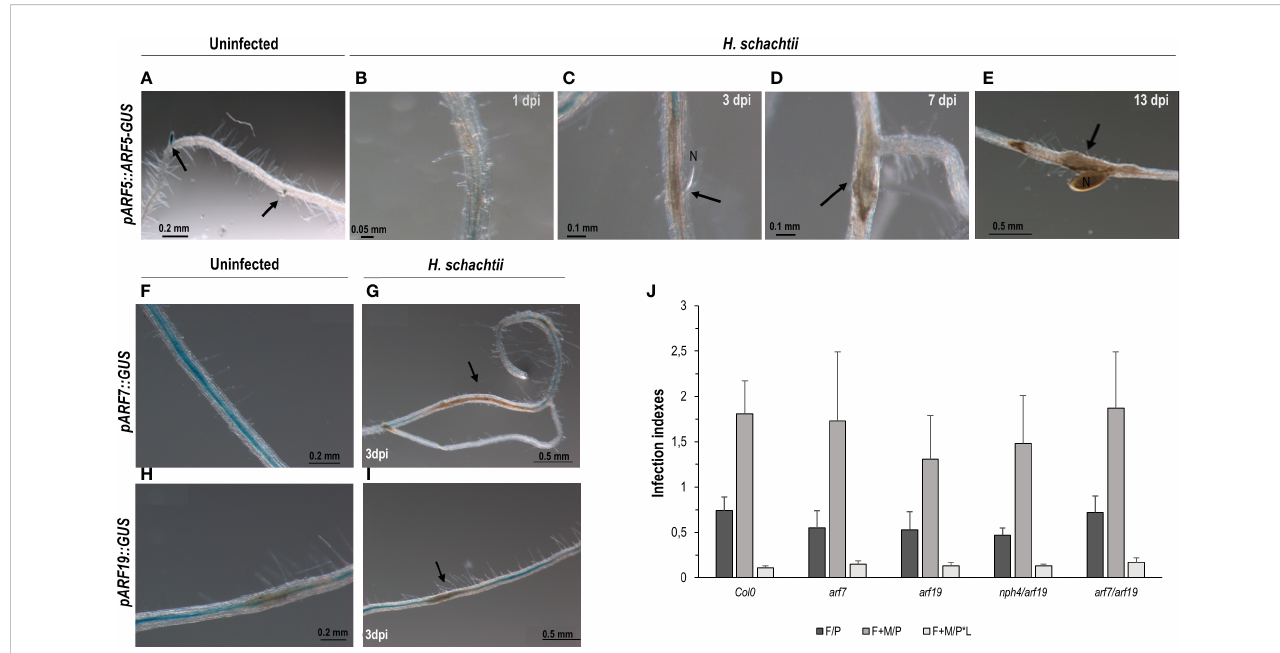
FIGURE 4 Activation patterns of auxin response factors crucial during lateral root and gall formation ( pARF5::ARF5-GUS , pARF19::GUS , pARF7::GUS ) in Arabidopsis roots infected with Heterodera schachtii . Expression in the root tips of uninfected tissue used as positive control ( A ; Olmo et al., 2020) Arabidopsis roots of pARF5::ARF5-GUS infected by H. schachtii showed no GUS signal in any of the infection stages assessed, either early (1, 3, 7 dpi; B – D ) or medium late (13 dpi, E ). The pARF7::GUS and pARF19::GUS lines showed a GUS signal extended along the roots and sometimes patchy in uninfected tissues (F, H) with no obvious de fi ned pattern different in syncytia (G, I) . Mutant lines corresponding to ARF7 or ARF19 either single ( arf7 , arf19 ) or double ( arf7/19 , nph4/arf19 ) mutants, showed no signi fi cant differences either in the number of females per plant (F/P), or females + males per plant (F + M/P), or the number of females + males per plant normalized to the root length (F + M/P ∗ L; J ; Student ’ s t-test; p <0.05), named as infection indexes in the Y axis. Scale bars as indicated. At least n ≥ 40 independent plants were assayed for GUS per independent line and for the infection parameters of the arf7 , arf9 , arf7/19 , and nph4/arf19 mutant lines and its corresponding control Col-0. At least three independent experiments per line were